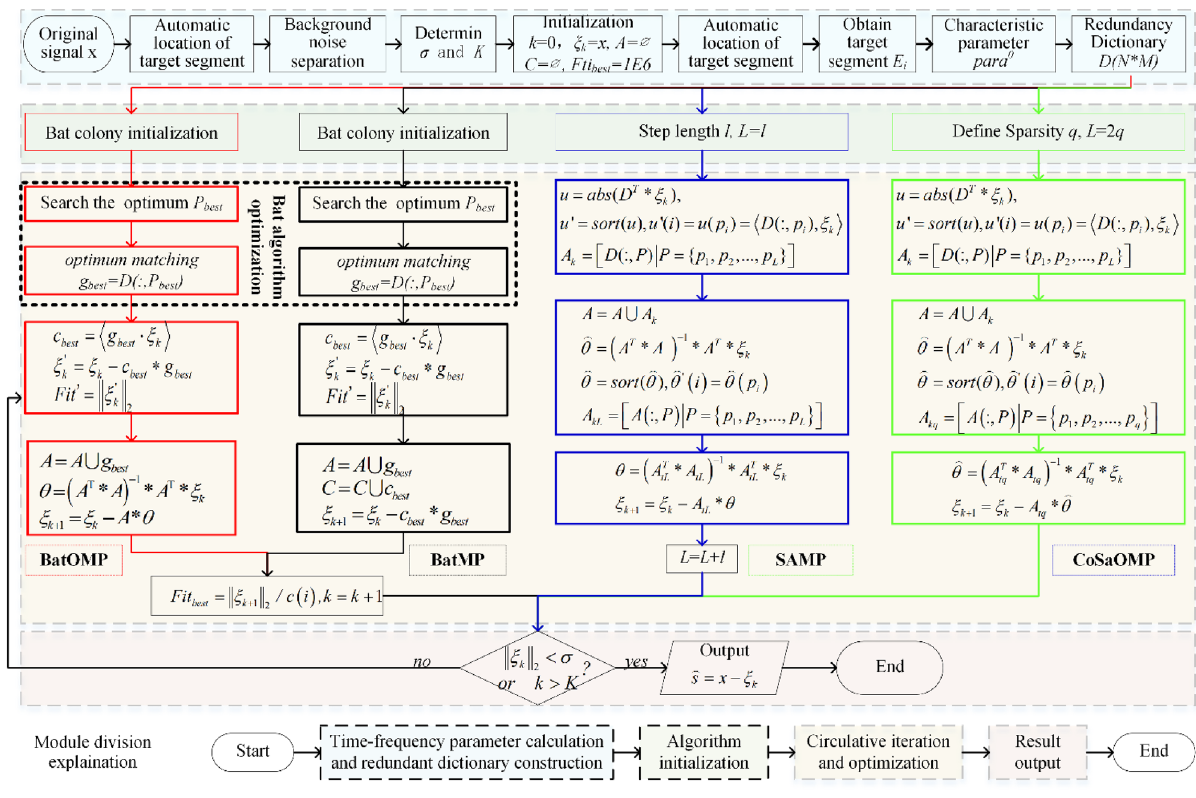
Figure 5. The overall flow chart of signal extraction